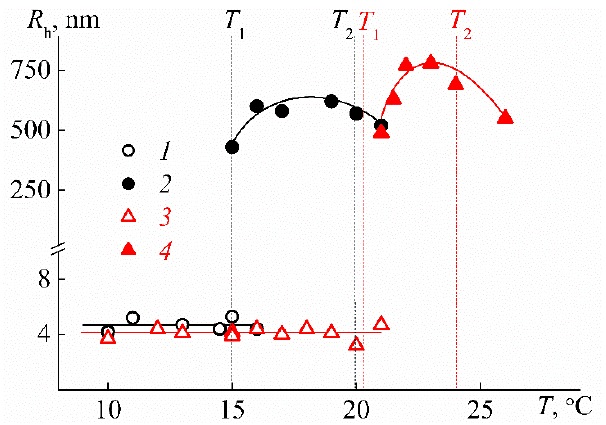
Figure 13. Dependencies of radii R f (1, 3) and R s (2, 4) on temperature T for PEI-1 (1 , 2) and PEI-2 (3, 4) solutions with concentration c = 0.0280 g cm –3 .